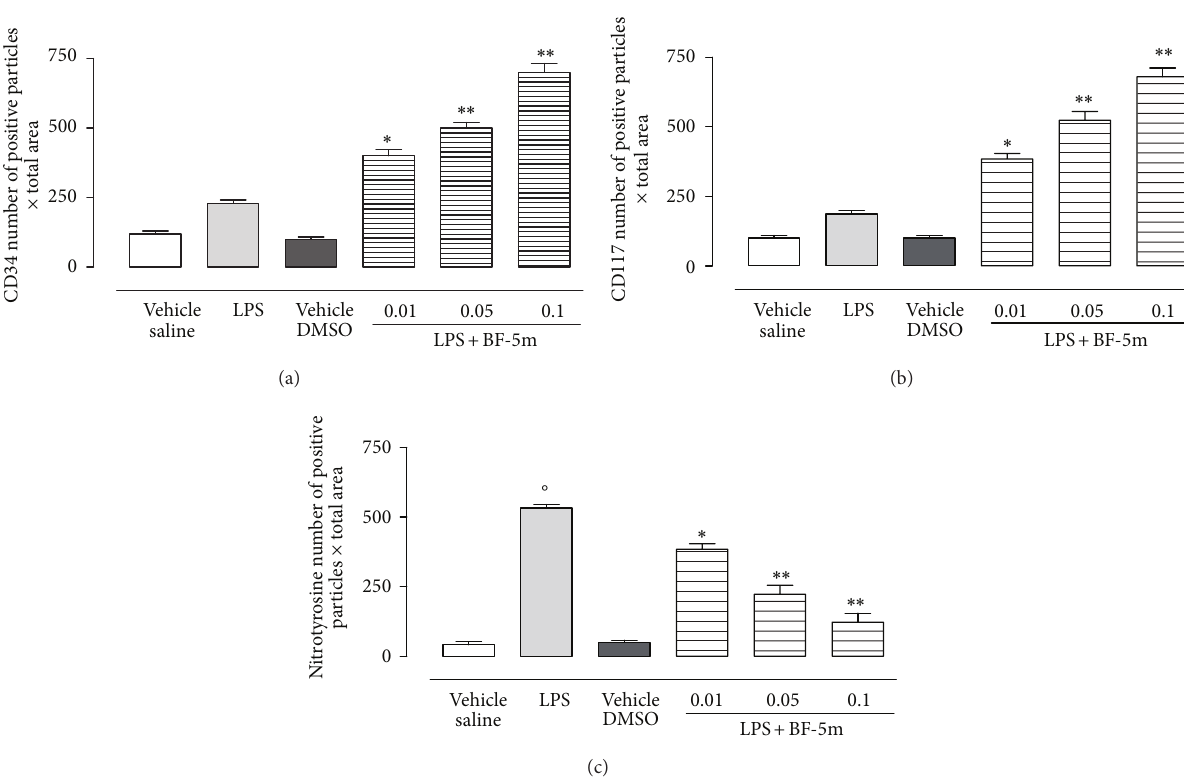
Figure 8: Number of CD34 + , CD117 + , and nitrotyrosine positive particles per area analyzed by immunohistochemistry. 20 microscopic fields were counted under 200x magnification in vehicle, LPS, and LPS+BF-5m 0.01; 0.05; 0.1 𝜇 M/rat. Values are mean ± SEM of 𝑛 = 6 observations for each group. ∗ 𝑃 < 0.05 and ∗∗ 𝑃 < 0.01 versus LPS-treated group; ∘ 𝑃 < 0.01 versus vehicle saline group.